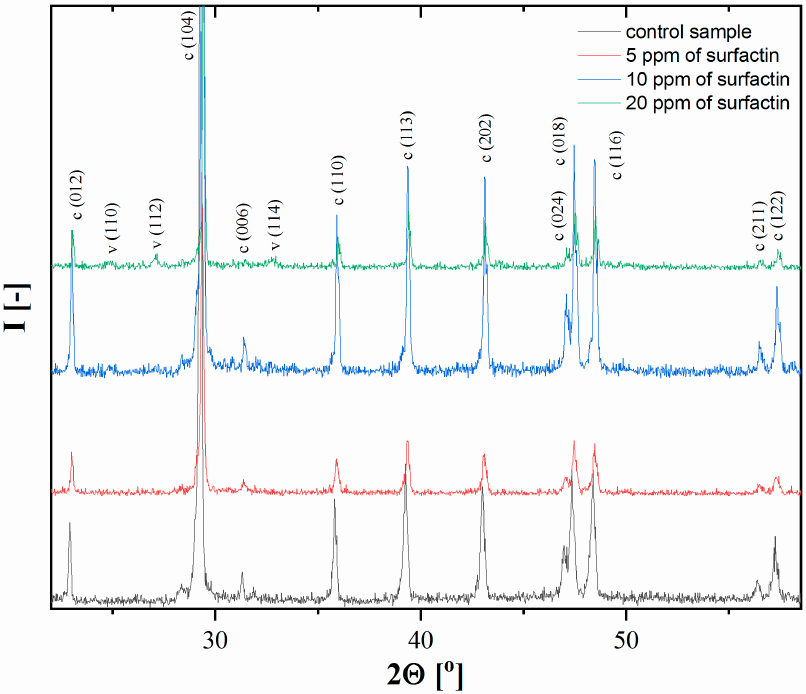
Figure 2. XRD patterns of calcium carbonate precipitated at different surfactin concentrations after 24 h of ageing. The concentration of CaCl 2 and Na 2 CO 3 was 5 mM (c-calcite, v-vaterite).